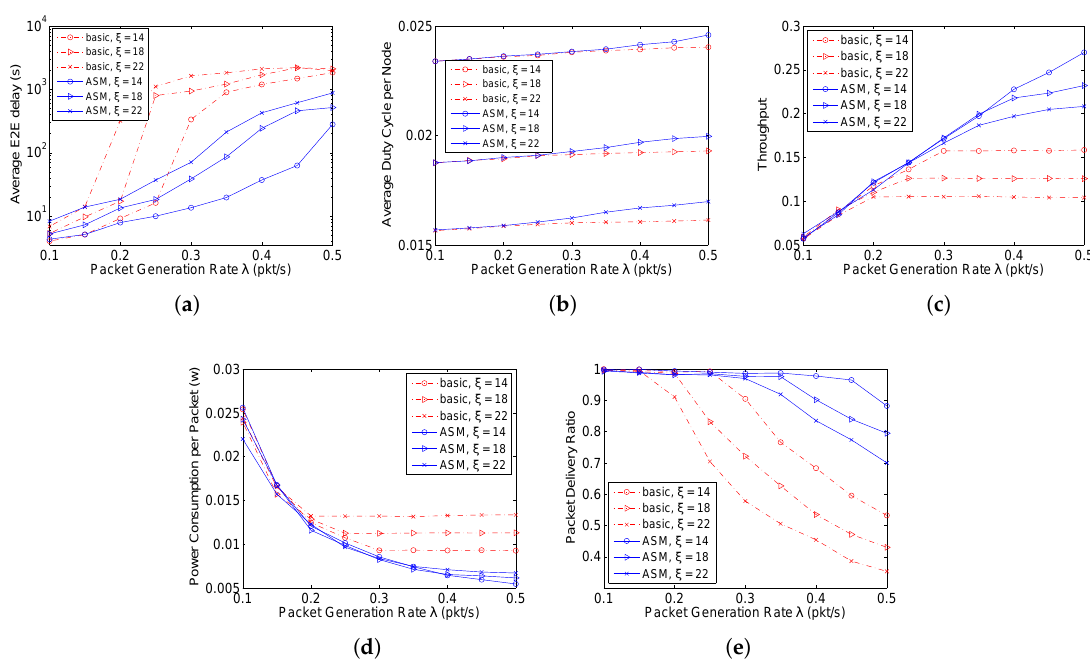
Figure 9. Performance evaluation in the 2D random network scenario. ( a ) Average E2E delay (7-hops). ( b ) Average duty cycle. ( c ) Throughput. ( d ) Average power consumption. ( e ) Packet delivery